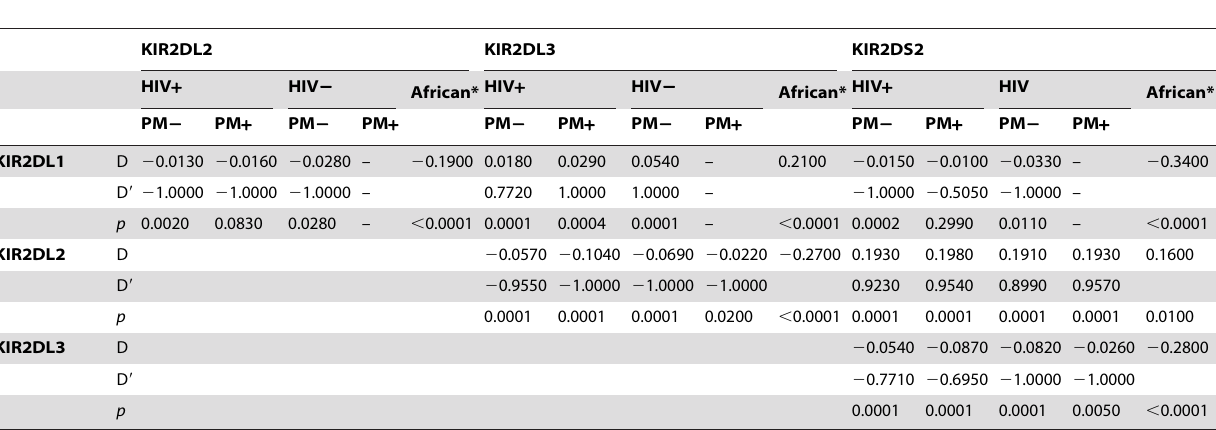
Table 5. Linkage disequilibrium (LD) for pairs of KIR genes in HIV-1 negative and HIV-1 positive women, by placental malaria (PM)